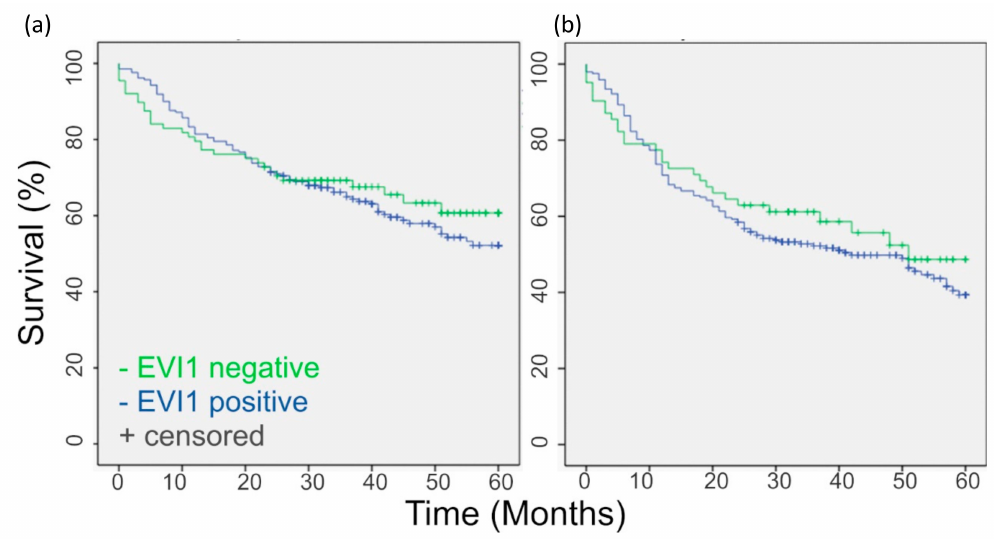
Figure 6. EVI1 expression does not correlate with survival data. The slight di ff erences in five year ( a ) Overall Survival (OS) and ( b ) Disease-Free Survival (DFS) are not statistically significant ( p >